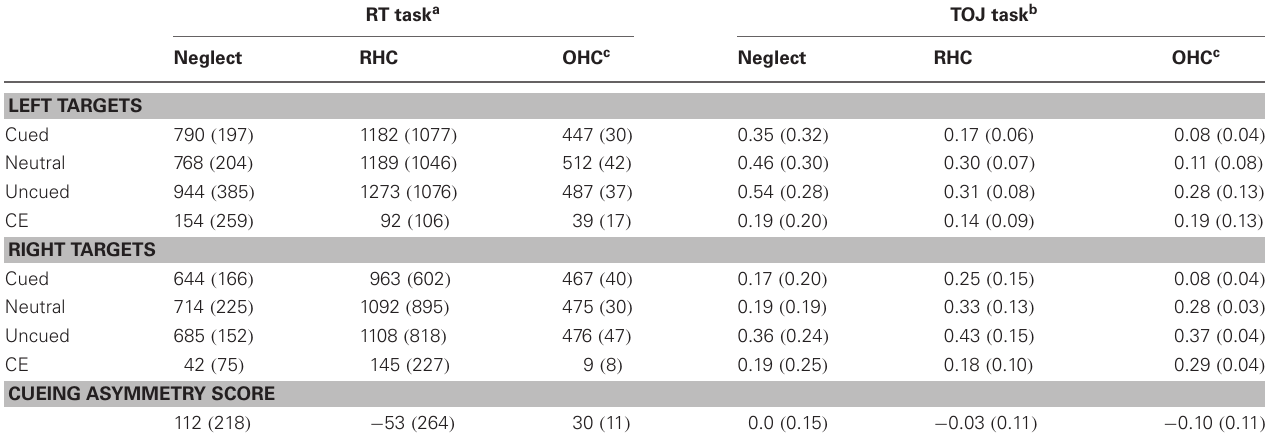
Table 3 | Means and SDs (in brackets) for each condition and task; means and SDs for the CEs and cueing asymmetry scores have been derived from subtractions for each individual participant.